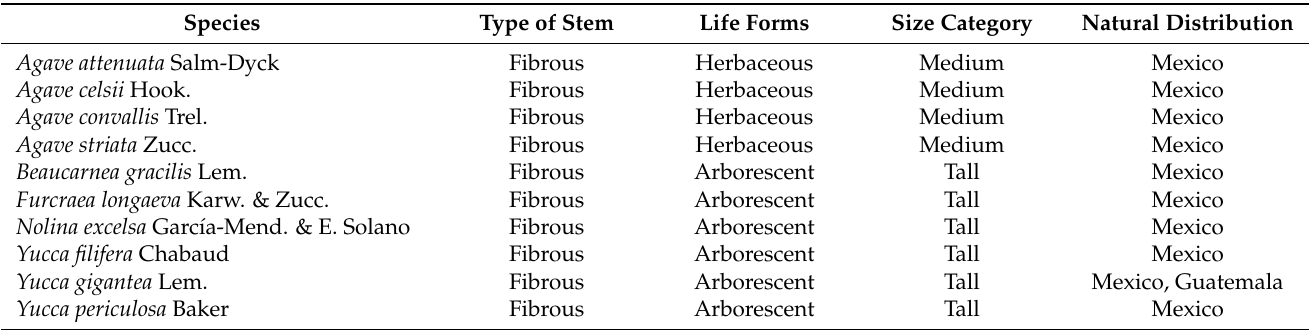
Table 1. Asparagaceae